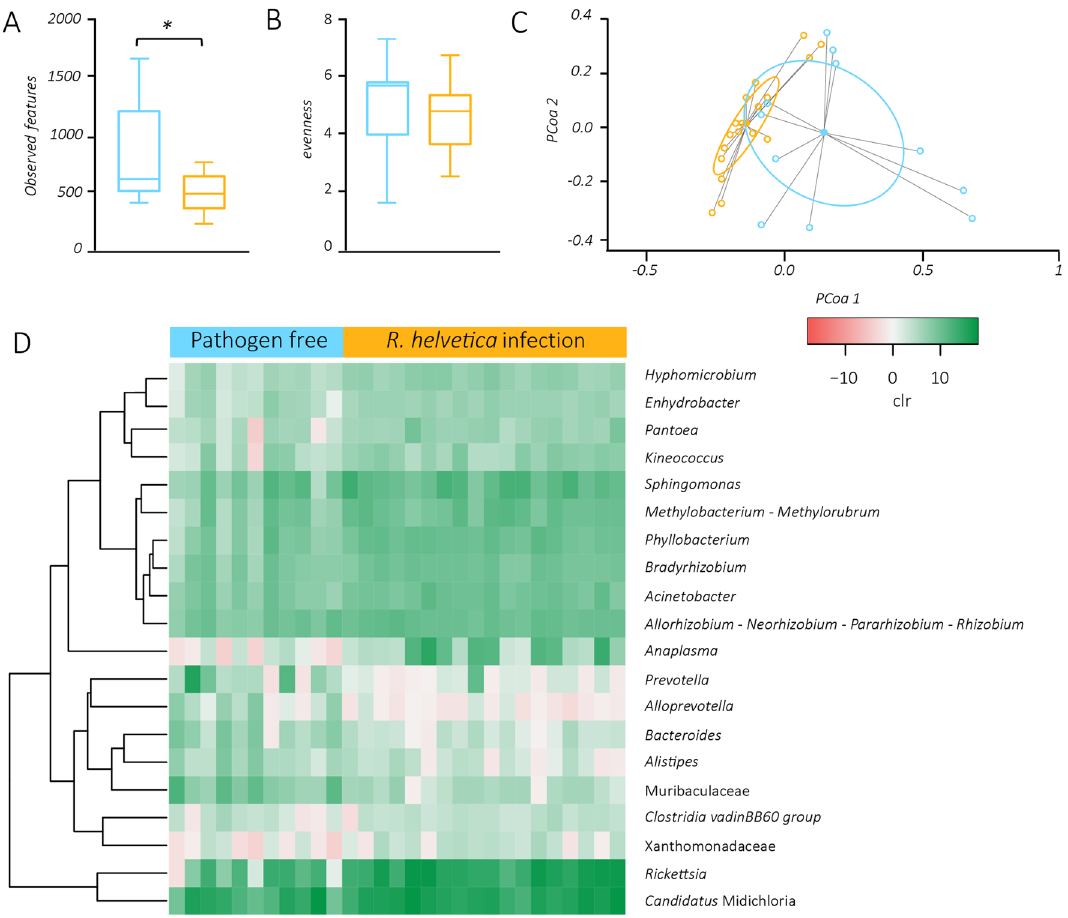
Figure 2. Impact of R. helvetica infection on tick microbial diversity and taxa bacterial abundance. ( A ) Comparison of alpha-diversity with observed features index for R. helvetica -infected (orange) and pathogen- free (blue) samples (* p = 0.015). ( B ) Comparison of alpha-diversity with evenness index for R. helvetica - infected (orange) and pathogen-free (blue) samples ( p = 0.393). ( C ) Comparison of beta-diversity with Bray Curtis dissimilarity index for R. helvetica -infected (orange) and pathogen-free (blue) samples. Small circles represent samples, and ellipses represent centroid position for each group ( F = 5.313; p = 0.001; stress = 0.130). Beta dispersion of the two sets of samples. Small circles represent samples, and ellipses represent dispersion of samples. This test use Principal Coordinate Analysis (PCoA), it is used to explore and to visualize variability in a microbial community. ANOVA test was performed and showed that beta dispersion of the two sets of samples is significantly different ( p = 4.775e−05). ( D ) Dendrogram heatmap resulting from the heatmap.2 function implemented on R studio 73 . The taxa were clustered based on relative abundance (calculated as clr transformed values). Each column represents the clr values for bacterial taxa per sample and per group. Each line represents bacterial taxa with significant changes between the two datasets. Color represent the clr helvetica -positive samples and displayed them as co-occurrence sub-networks. The pathogen-free sub-network contains 161 taxa positively or negatively connected with at least one of the keystone taxa (Fig. 4C). Specifically, positive and negative associations were found for Corynebacterium (45 positive and 74 negative) Staphylococ- cus (46 positive and 79 negative) and Muribaculaceae (91 positive and 35 negative). The R. helvetica -positive